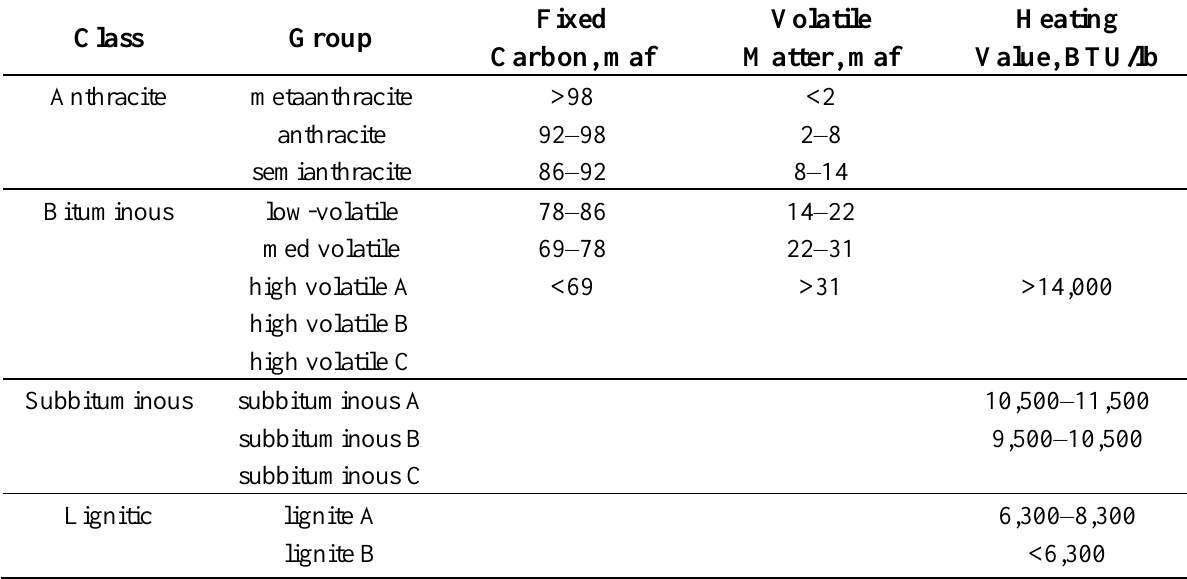
Table 2. ASTM classification of